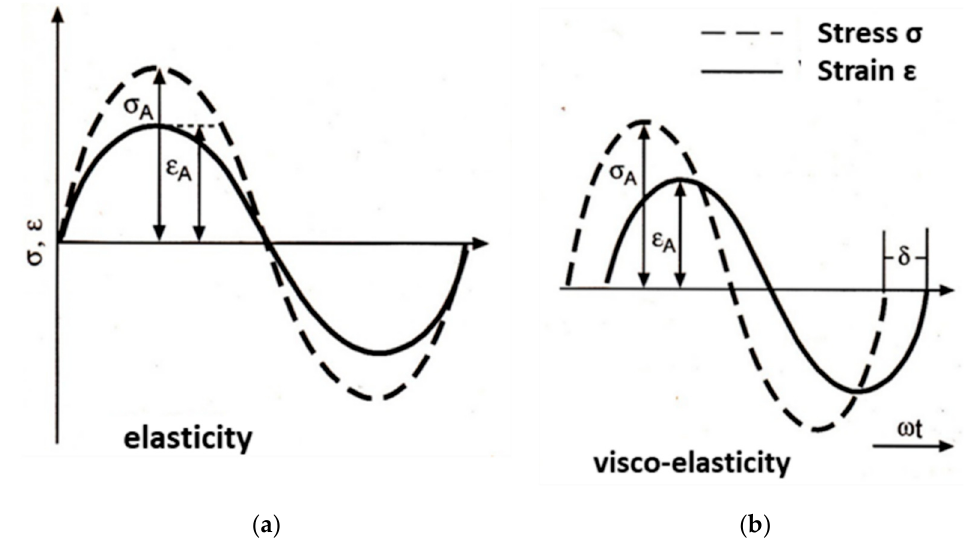
Figure 10. Stress–strain behavior of elastic ( a ) and visco-elastic ( b ) materials with an applied sinus deformation and a given frequency. The delay in the measured stress is determined by the phase shift δ [32].